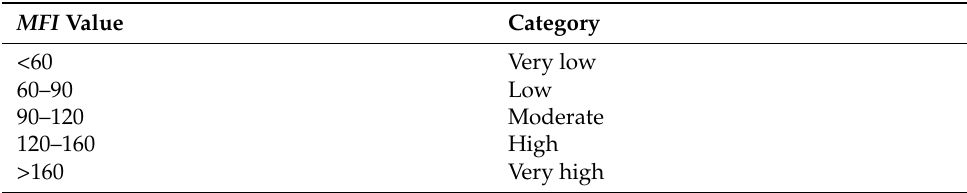
Table 3. Description of the MFI erosivity range